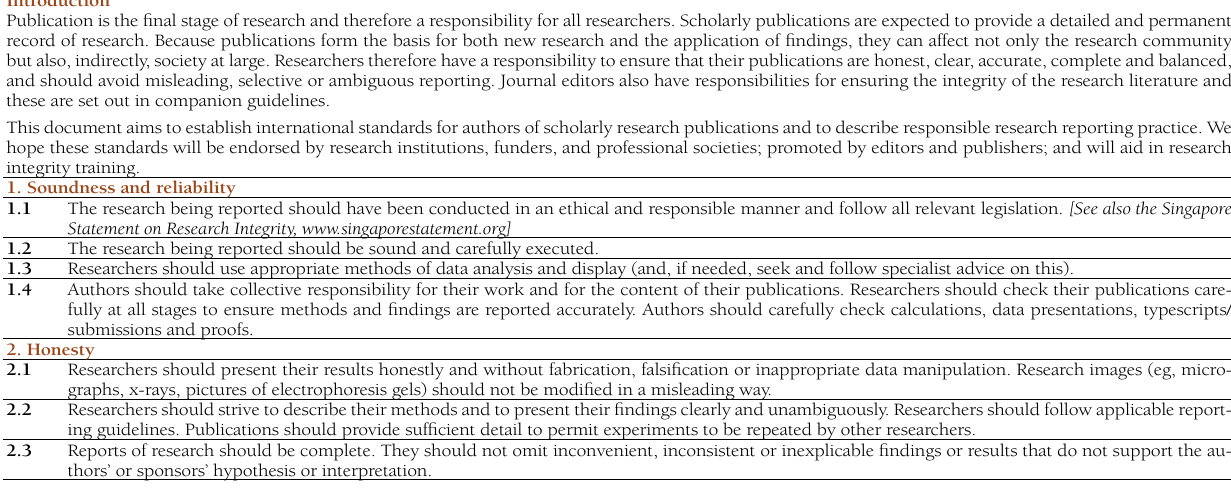
Table 1 Responsible research publication: International standards for